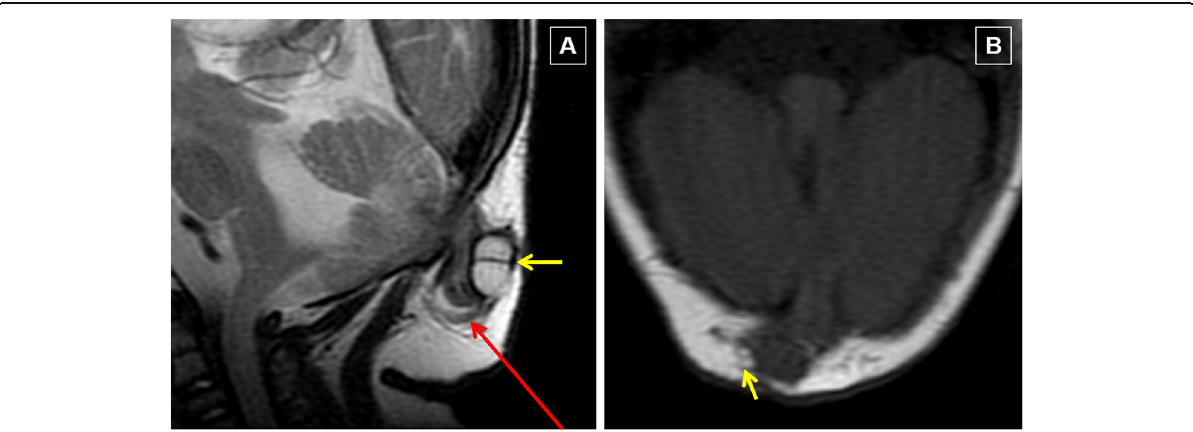
Fig. 11 Occipital meningoencephalocele with an associated dermoid. ( a ) (T2-weighted sagittal) shows occipital meningoencephalocele (long arrow) with an associated T2 hyperintense cystic appearing lesion (short arrow) along the peripheral aspect of the herniated sac. ( b ) (T1-weighted axial) image shows T1 hyperintense focus (short arrow) along the peripheral aspect of the herniated sac. Histopathology confirmed this lesion to be a